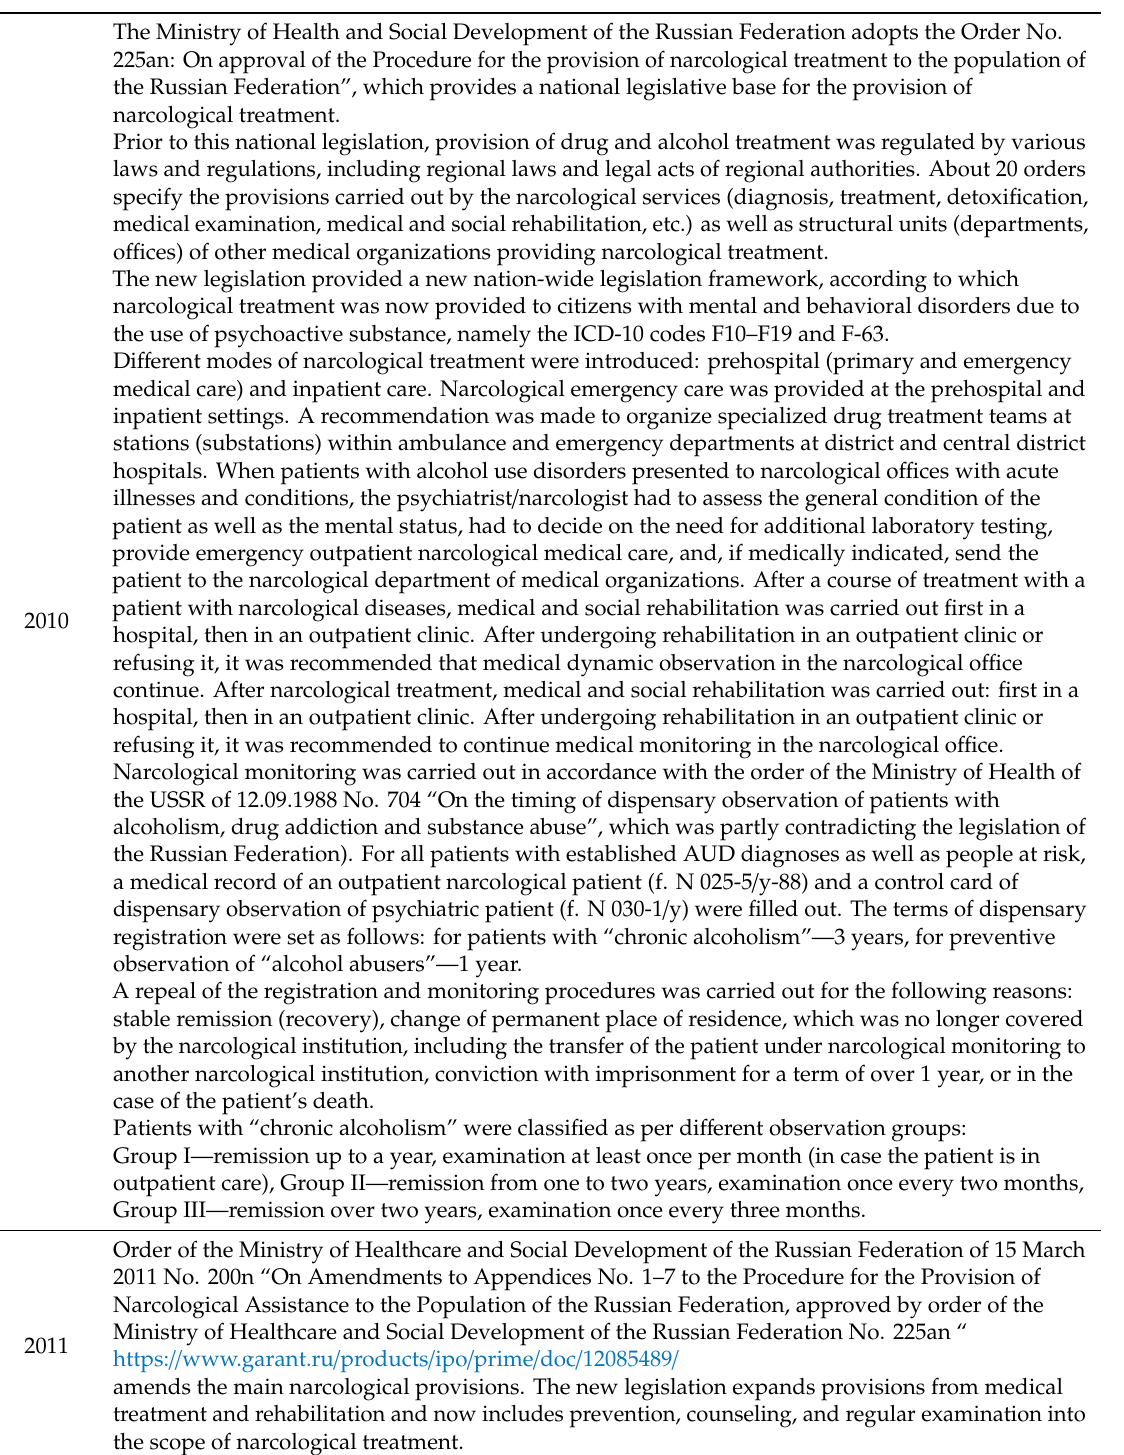
Table A8. Overview of the most important law changes related to the provision of specialized narcological treatment since 2009. Source: